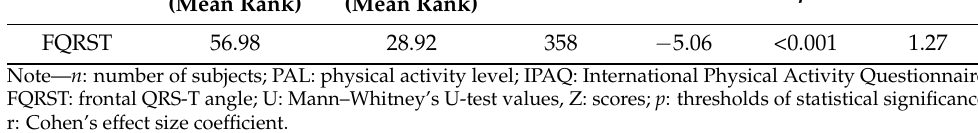
Table 3. Comparison of recorded parameters (Mann Whitney test) between group 2 ( n = 51, with moderate PAL) and group 3 ( n = 38, with high PAL), grouping variable IPAQ category. Variable Table 4. Comparison of recorded parameters (Mann Whitney test) between group 1 ( n = 35, with low PAL) and group 3 ( n = 38, with high PAL), grouping variable IPAQ category.